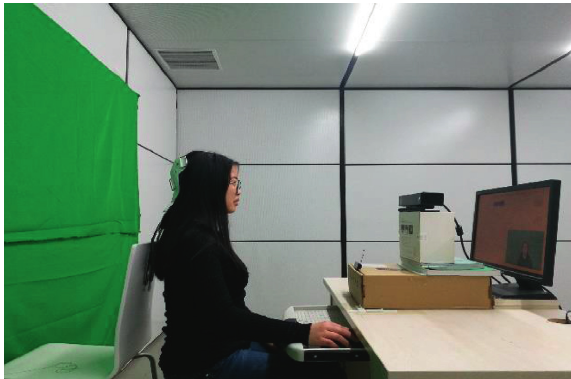
Figure 1: Kinect V2 recording data experimental